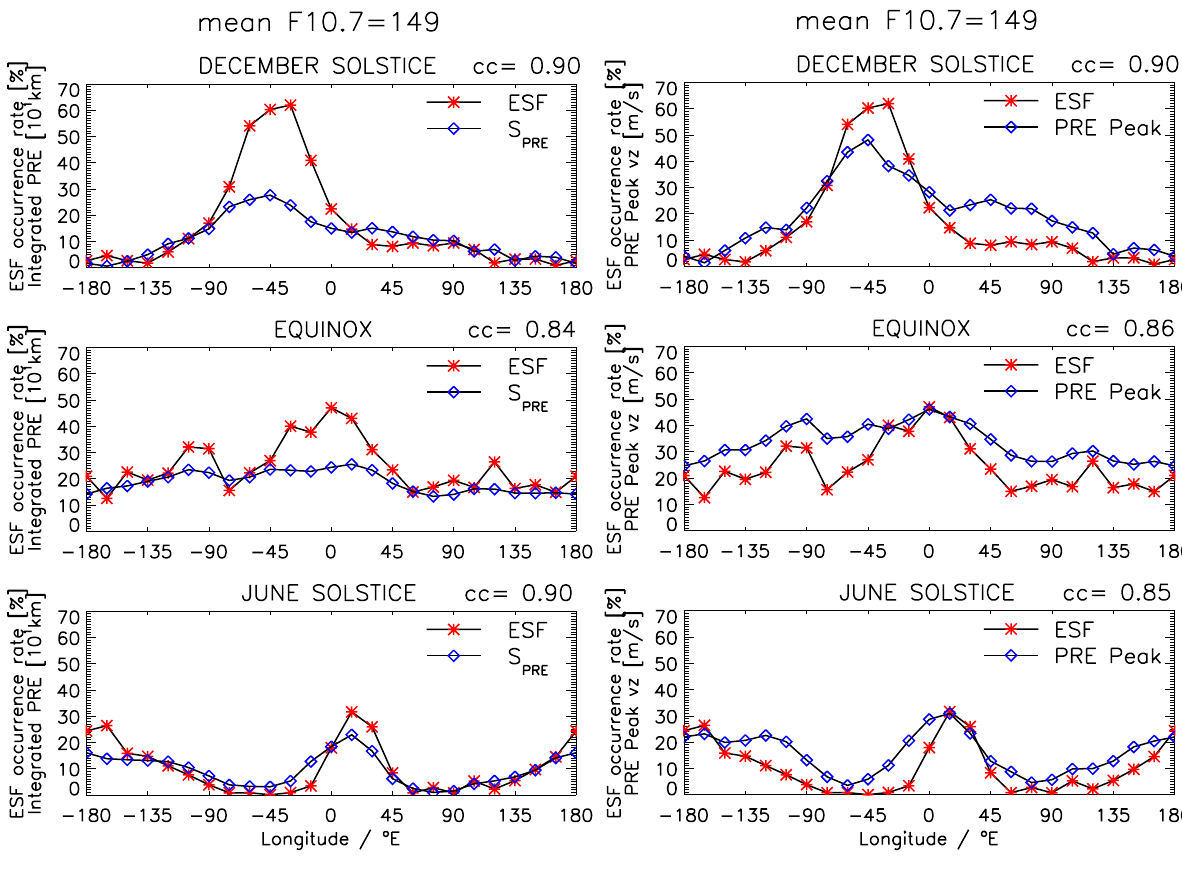
Fig. 3. Longitudinal variation of the occurrence rate of ESF magnetic signatures and integrated PRE plasma drift S PRE (left panel) and peak plasma drift velocity (right panel) for different